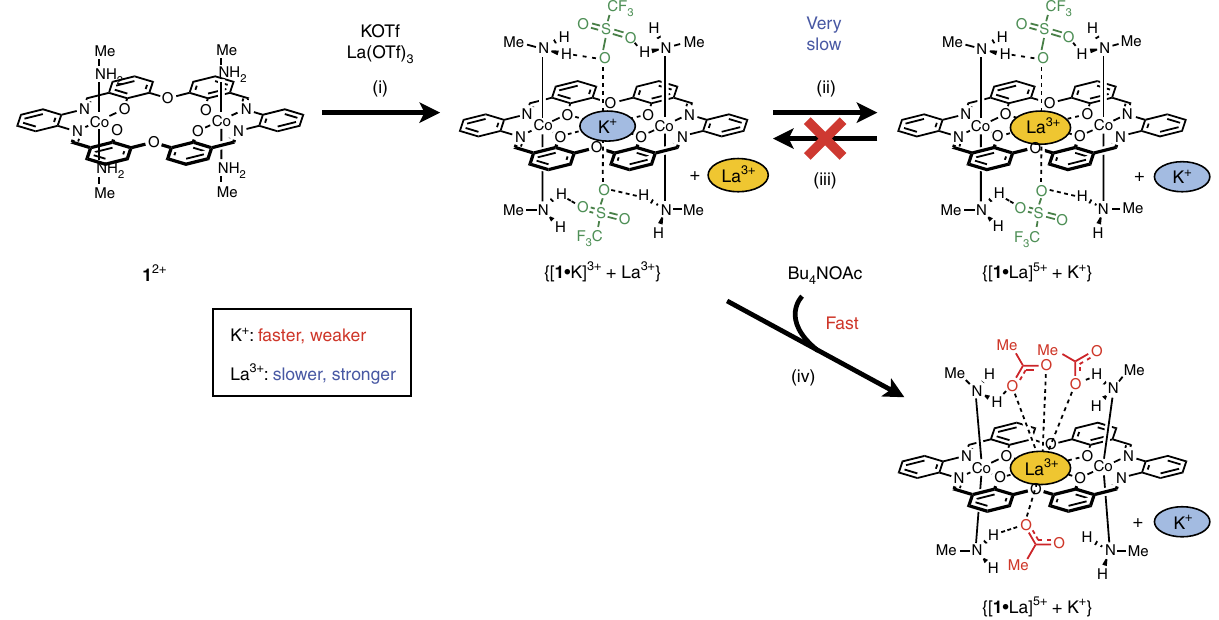
Figure 4 | Guest recognition and exchange behaviours of 1(OTf) 2 . When KOTf and La(OTf) 3 were added to the metallohost 1 (OTf) 2 at once, the kinetically trapped state {[ 1 (cid:2) K] 3 þ þ La 3 þ } was generated (i). While the conversion from the kinetically formed K þ complex to the thermodynamically more stable La 3 þ complex was exceptionally slow (ii, iii), the guest exchange was significantly accelerated by the addition of tetrabutylammonium acetate